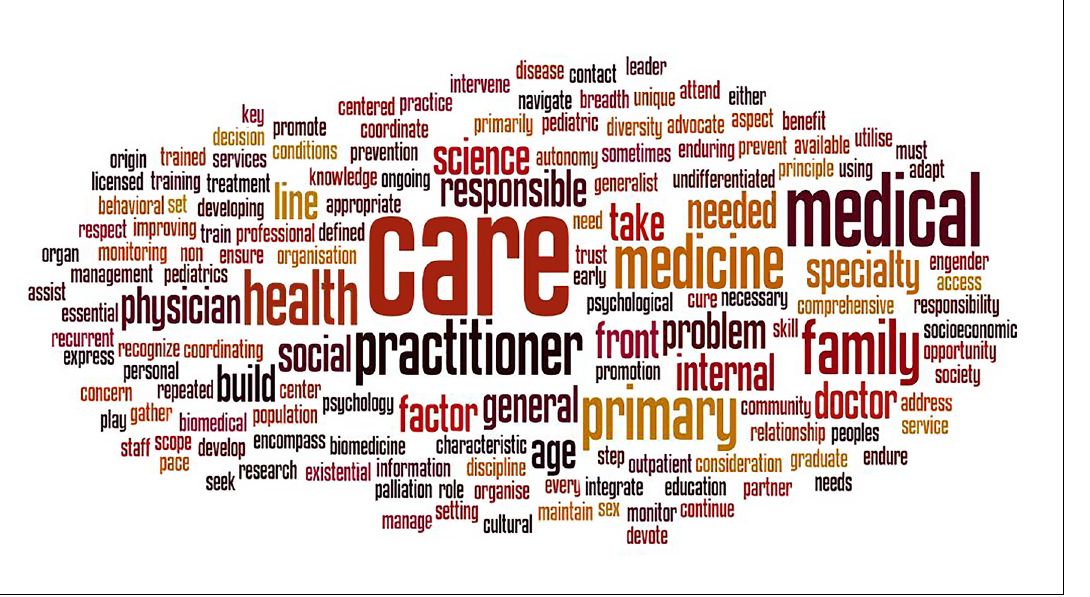
Figure 1. Tag cloud for General Practice/Family Medicine.